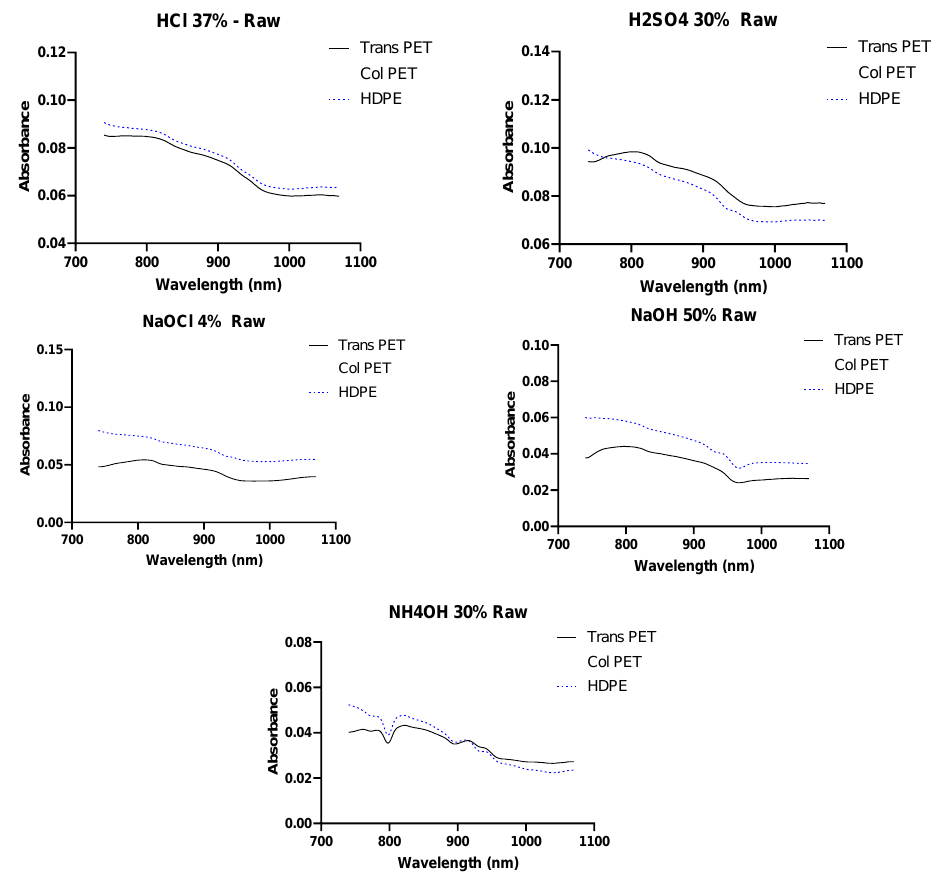
Figure 3. Examples of raw spectra of HCl 37%, H 2 SO 4 30%, NaOCl 4%, NaOH 50% and NH 4 OH 30% scanned through bottles of Transparent PET (Trans PET), Coloured PET (Col PET) and HDPE. Raw spectra were downloaded using the SCiO™ Lab application and then plotted using GraphPad Prism 8.0.1.